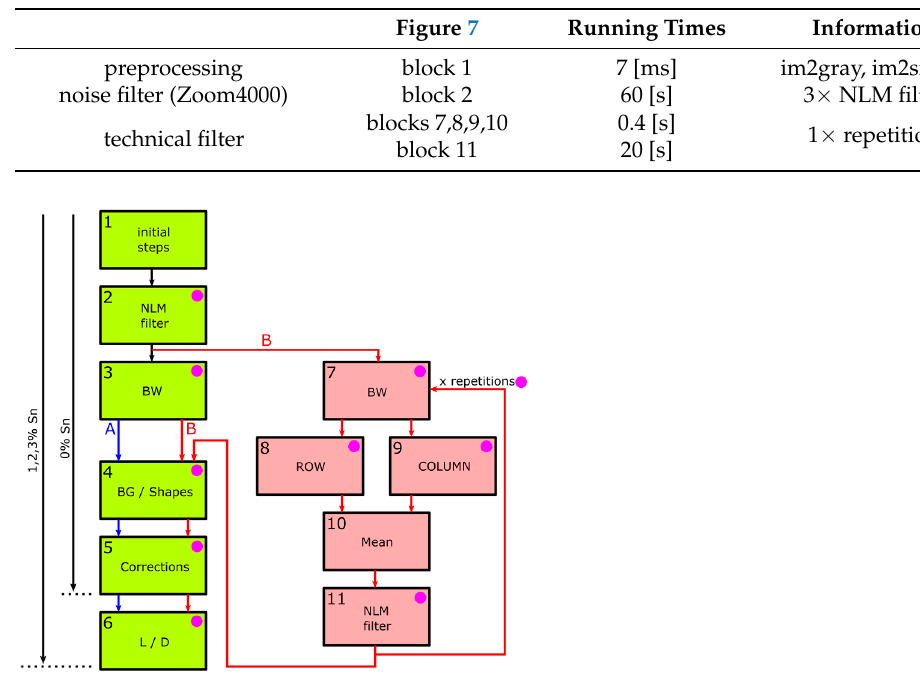
Figure 7. Segmentation and classification scheme.